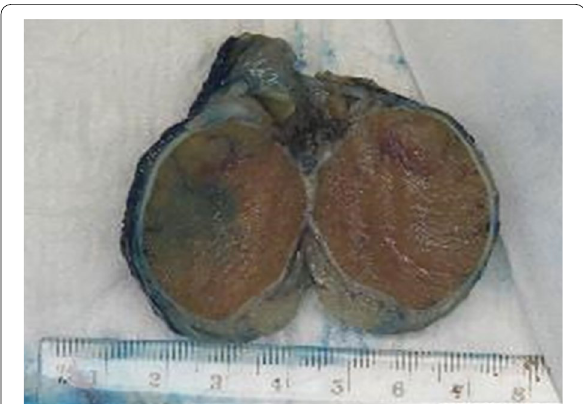
Fig. 3 An orchidectomy specimen was received with an attached spermatic cord, revealing a 1 cut sections. The surface is tan homogenous in an unremarkable testicular